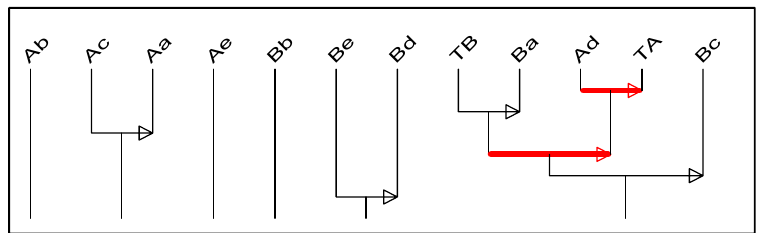
Figure 6. Implicative tree for didactic variables Type A (student´s solution to Task A) and Type B (student´s solution to Task B).